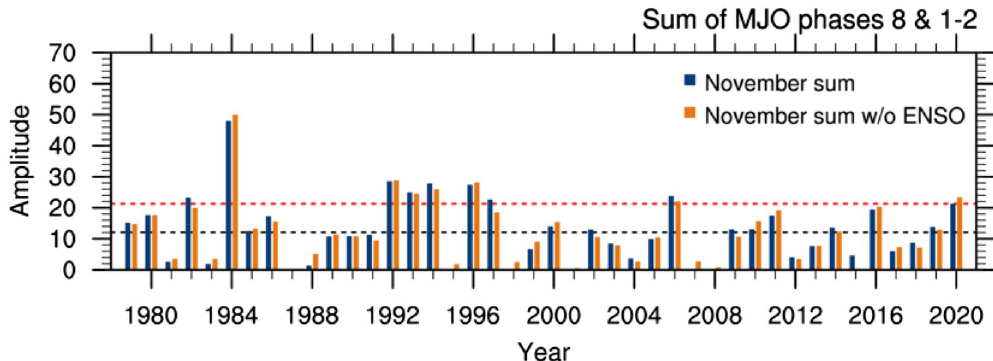
Figure 9. Time series of the sum of the daily MJO amplitudes for Phases 8, 1 and 2 during November (referred to as MJO812). MJO amplitudes in Phases 8, 1, and 2 were summed only if they were equal to or greater than 1 over more than one day in the month. The blue bars show the sum of the daily raw amplitudes for the occurrence of Phases 8, 1, and 2, and the orange bars show the same but with the linear dependence on the Niño 3.4 SST index removed. The black and orange coloured horizontal dashed lines indicate the mean and the positive 1 standard deviation of the ENSO-free MJO812 time series from its mean,